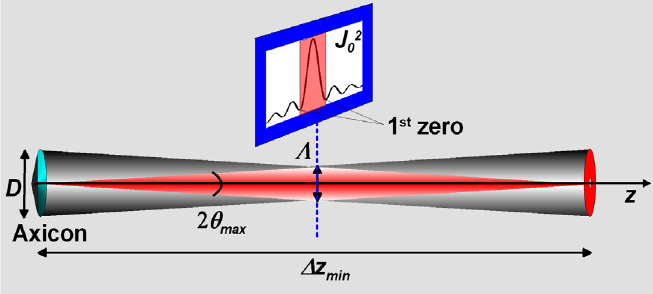
Figure 3. Self-apodized truncation condition for the aperture-less Bessel-like needle pulses (schematically, after ref. [44]). Curve on the separated blue plane: radial Bessel intensity profile, red area: central lobe, white area: not generated outer parts ( Λ = diameter of central lobe, z = propagation axis, D = axicon diameter, θ = maximum allowed half max = minimum extension of the needle-shaped nondiffracting zone, conical angle, Δ z min J = zero order first kind Bessel 0